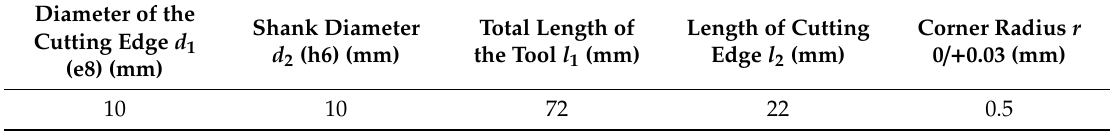
Table 2. Characteristic of three-edge end mill.